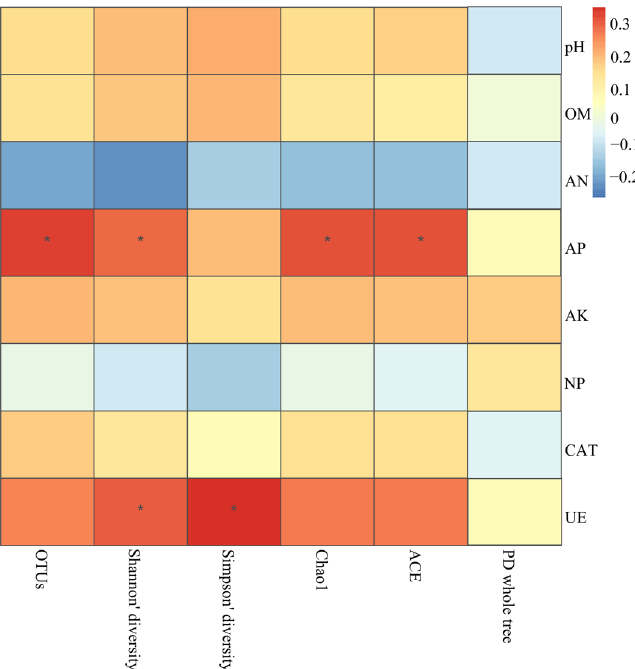
Figure 6. Spearman analysis showing the correlation between soil bacteria α-diversity indices, soil physicochemical properties, and enzyme activity in the ARMR system. The different color indicated the different correlation coefficients. The asterisks indicated the p values were less than 0.05.